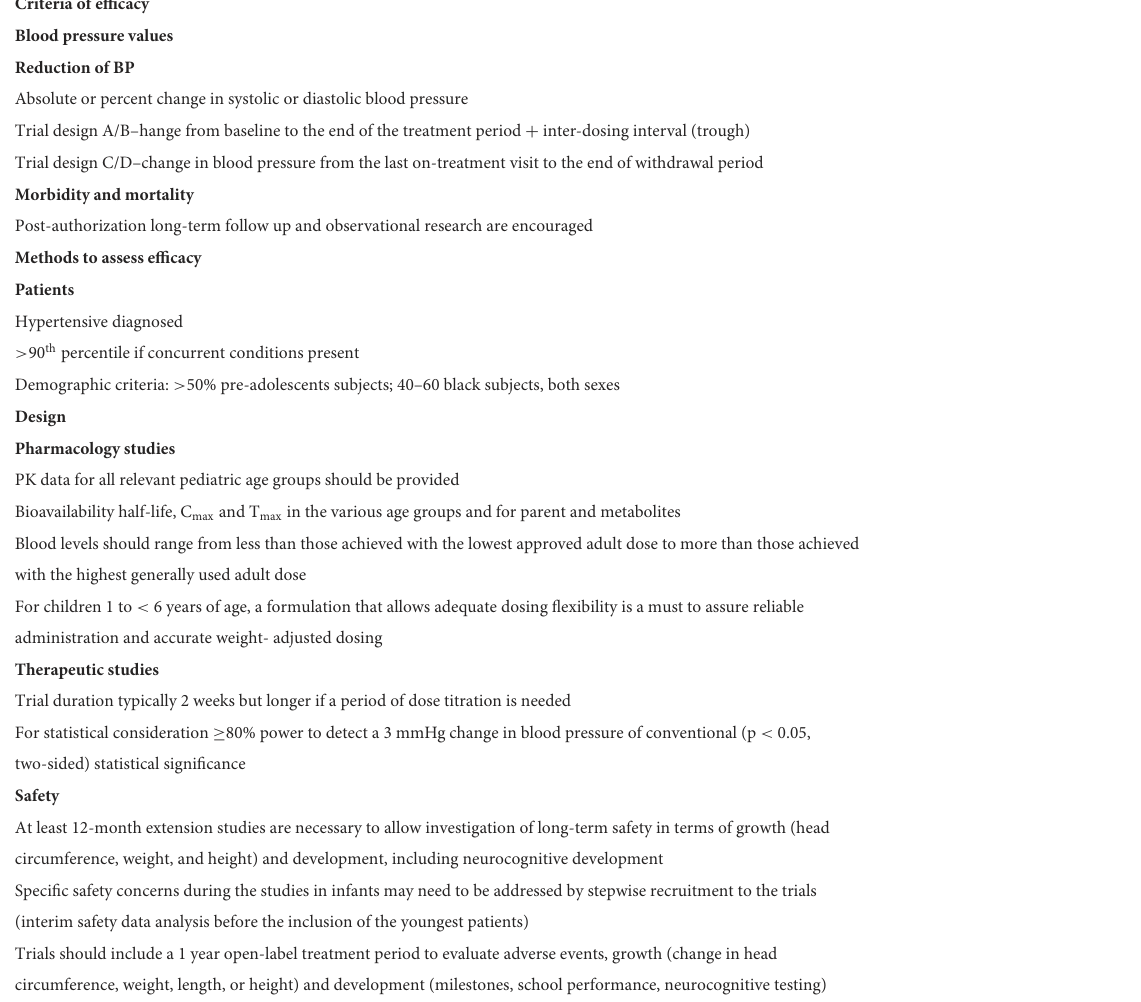
TABLE 2 Criteria for the methods to establish dosing recommendation and safety of antihypertensives from FDA agencies (16). Criteriaof